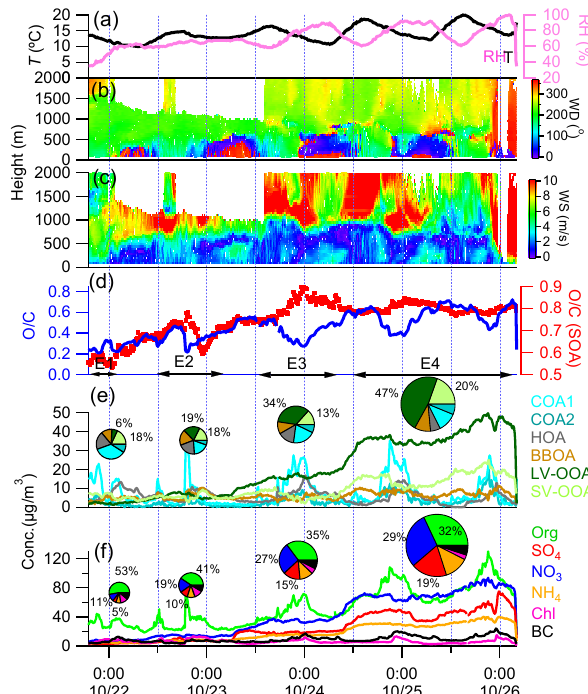
Figure 12. Evolution of meteorological variables including (a– c) relative humidity (RH), temperature ( T ) , and vertical profiles of wind direction (WD) and wind speed (WS); (d) O / C and O / C of secondary organic aerosol (SOA); (e) organic aerosol (OA) fac- tors; and (f) PM 1 species. The pie charts show the average chemical composition of PM 1 and OA for each stage. The numbers on the pie charts show the contributions of (e) semi-volatile oxygenated organic aerosol (SV-OOA) and low-volatility oxygenated organic aerosol (LV-OOA) and (f) organics, nitrate, and sulfate.